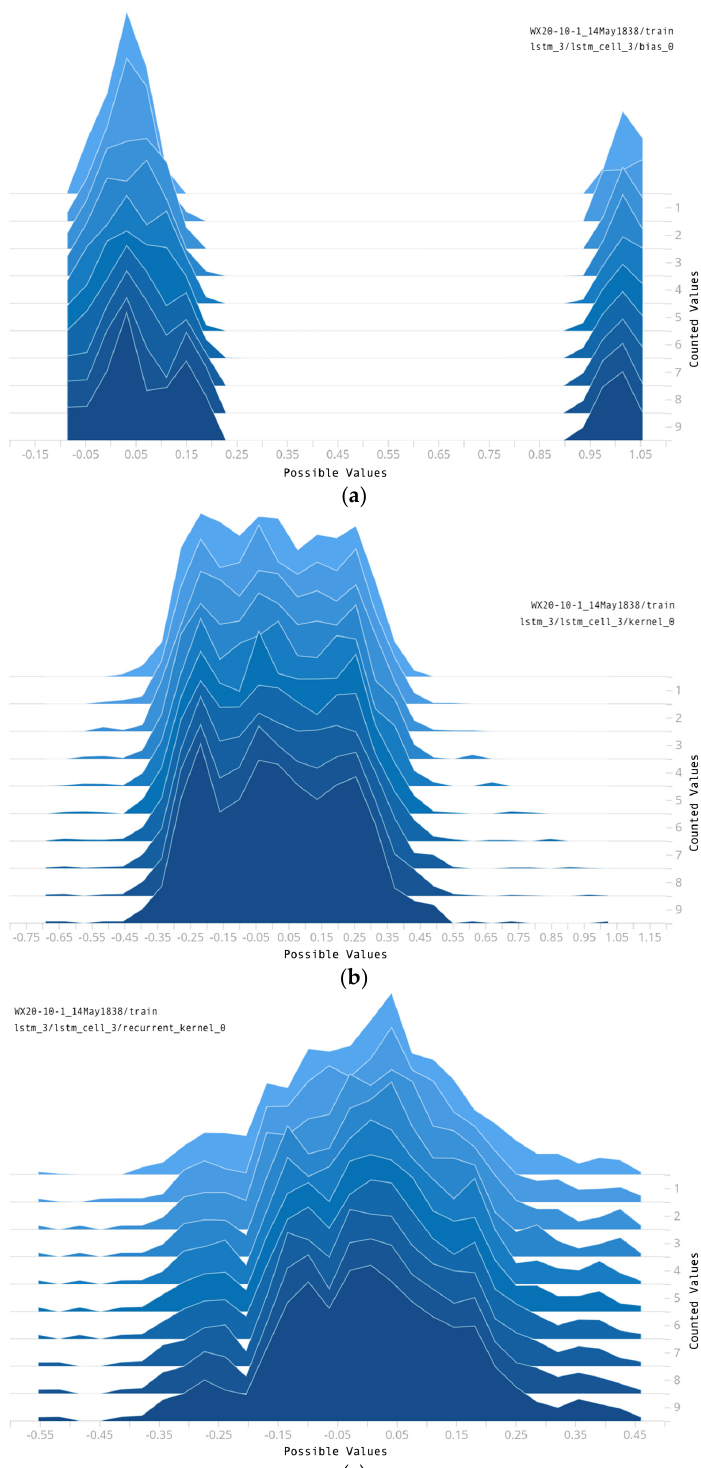
Figure 8. Weather events : histogram plots. ( a ) Bias LSTM cell three; ( b ) Kernel LSTM cell three; ( c ) Recurrent kernel LSTM cell three.